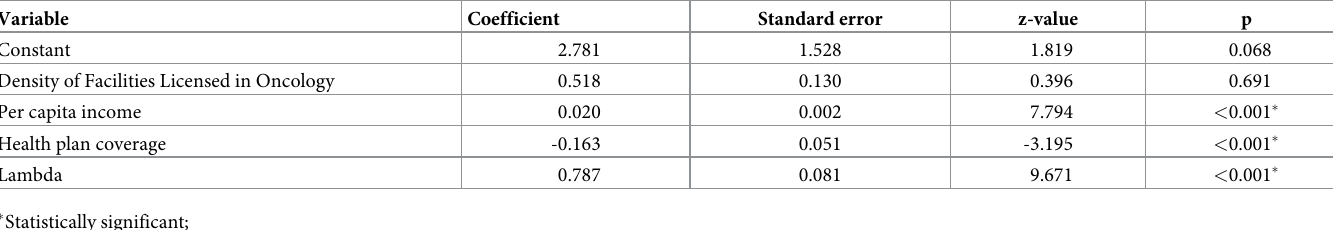
Table 2. Spatial regression analysis of age-adjusted lung cancer mortality rates and its association with demographic and socioeconomic and healthcare services supply indicators, per IRUA, Brazil,